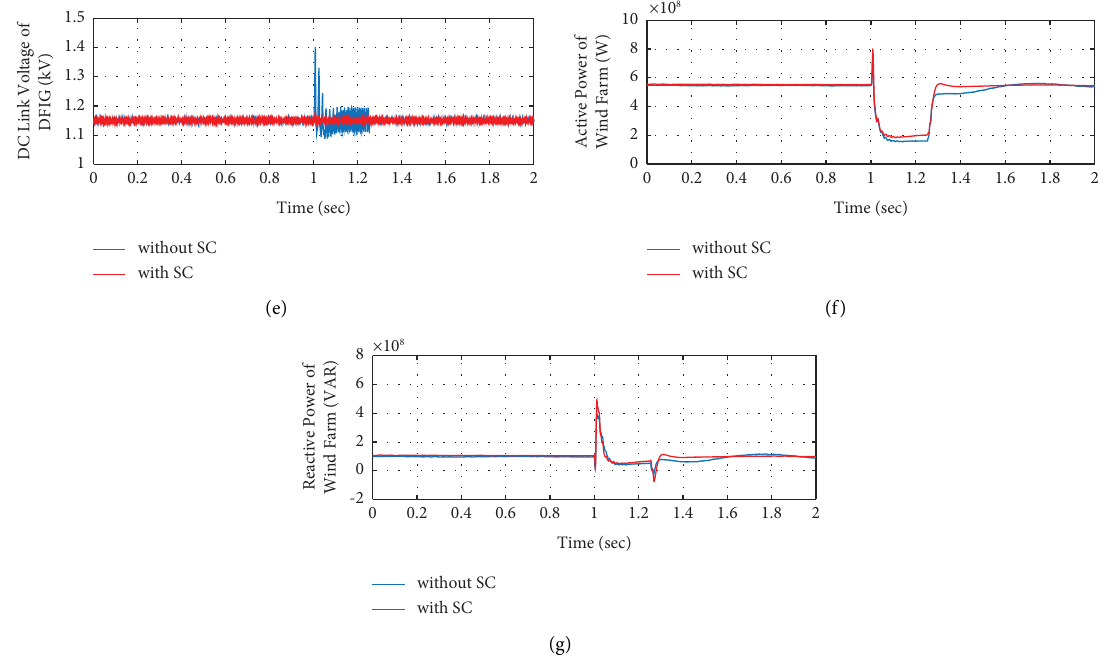
Figure 16: Performance during a single-line-to-ground fault. (a) Te AC voltage at B575, (b) the DC voltage of the APF capacitor, (c) the load active power, (d) the load reactive power, (e) the DC-link voltage of the back-to-back converter, (f) the total active power of the wind farm, and (g) the total reactive power of the wind